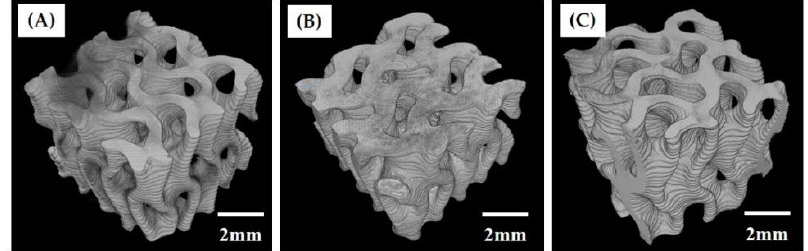
Figure 3. Representative micro-computed tomography ( µ -CT) images of the hierarchically porous CaP scaffolds manufactured using a range of camphene-camphor amounts: ( A ) 40 vol %, ( B ) 50 vol %, and ( C ) 60 vol %.